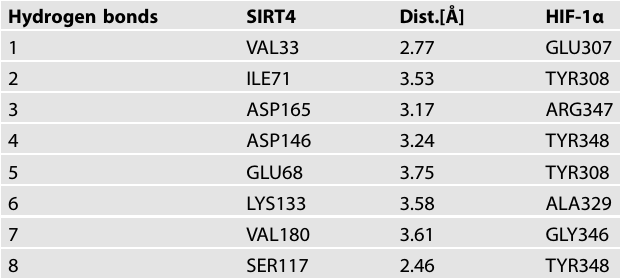
Table 1. The binding sites of hydrogen bonds between SIRT4 and HIF- 1 α (proposed from the docking